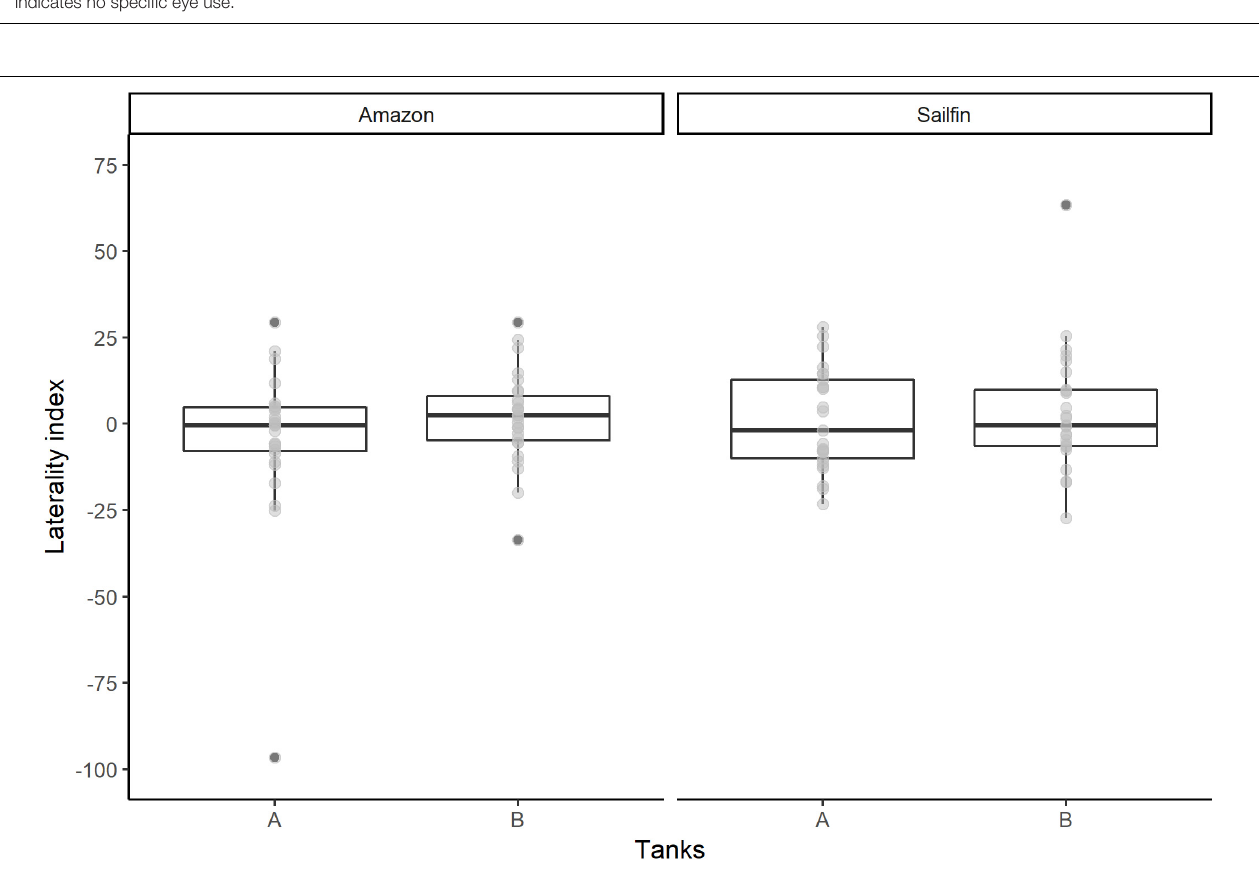
Frontiers in Ecology and Evolution |